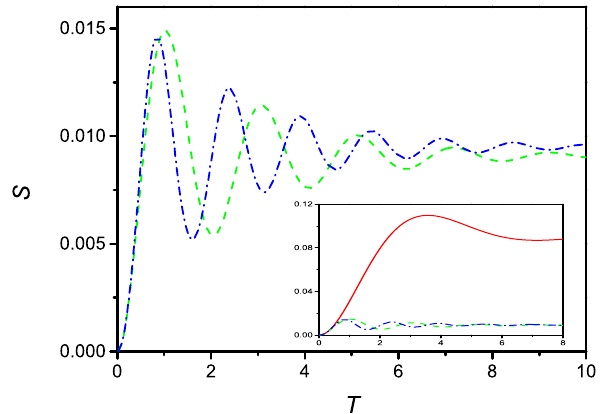
Figure 8. Time evolution (in dimensionless units) of the surface density of adsorbed particles in the presence of linear (dashed), and quadratic (dash-dotted), saturation effect. The curve are drawn for u = 0.1, r = 100 and ε = 5 ε c . Observed in the inset, comparison between the time evolution of S in the absence of saturation effect (full), with linear (dashed), and quadratic (dash-dotted) saturation